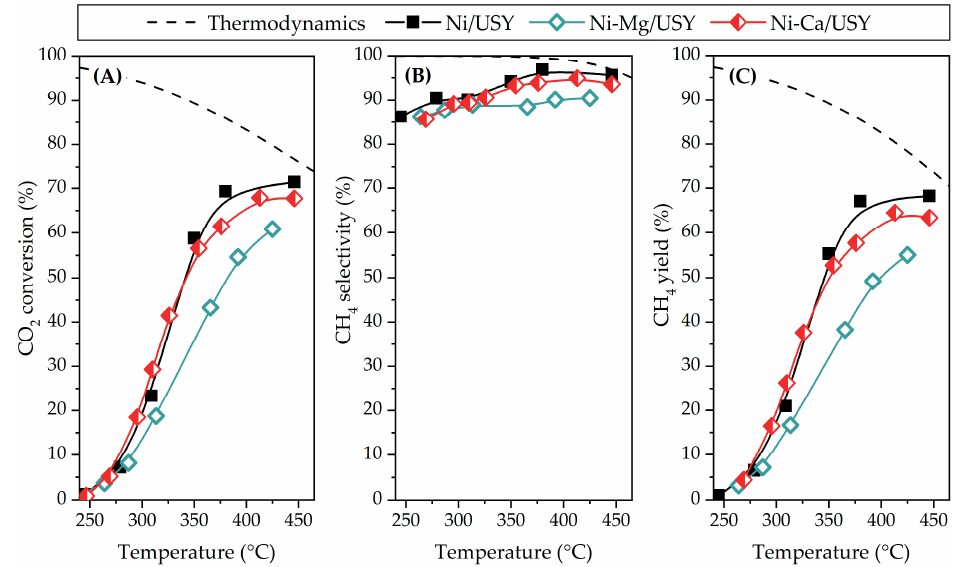
Figure 8. Catalytic performances obtained for Ni-AE/USY catalysts after reduction at 470 °C: ( A ) CO 2 conversion; ( B ) CH 4 selectivity and ( C ) CH 4 yield. Operating conditions: 1 bar, 86 100 mL h − 1 g cat − 1 and CO 2 :H 2 :N 2 = 9:36:10.